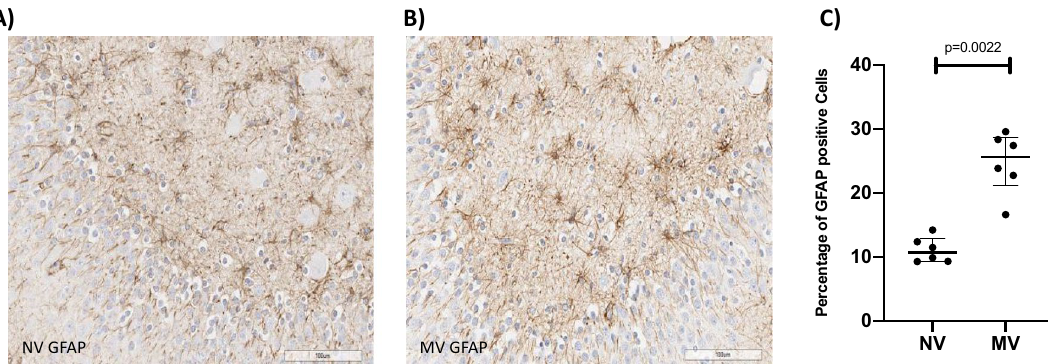
Figure 5. Slide of an NV subject’s hippocampus ( A ) and an MV subject’s hippocampus ( B ) after staining by GFAP, showing normal cells (blue) and GFAP-positive cells (brown). ( C ) Dot plot showing percentages of